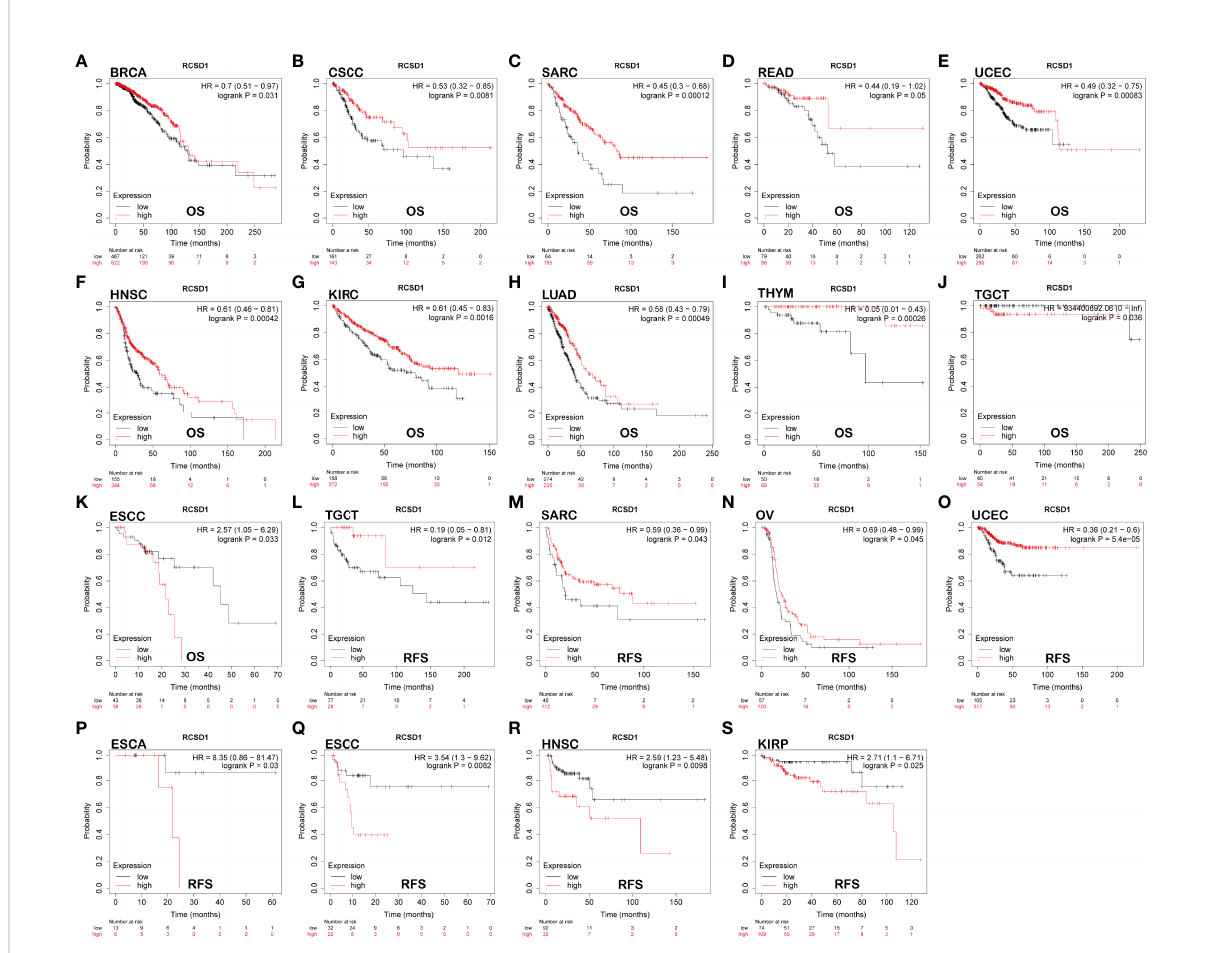
FIGURE 3 The relationship between the expression of RCSD1 and the prognosis of tumor patients was shown with Kaplan – Meier survival curves. OS of (A) BRCA, (B) CSCC, (C) SARC, (D) READ, (E) UCEC, (F) HNSC, (G) KIRC, (H) LUAD, (I) THYM, (J) TGCT and (K) ESCC. RFS of (L) TGCT, (M) SARC, (N) OV, (O) UCEC, (P) ESCA, (Q) ESCC, (R) HNSC and (S) KIRP. OS, Overall Survival; RFS, Relapse Free